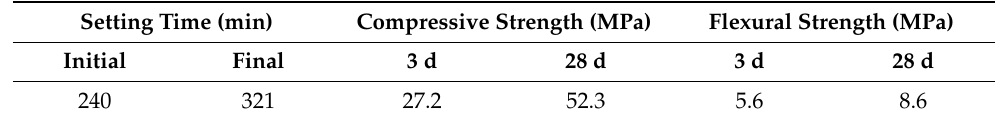
Table 1. The performance index of the ordinary Portland cement.